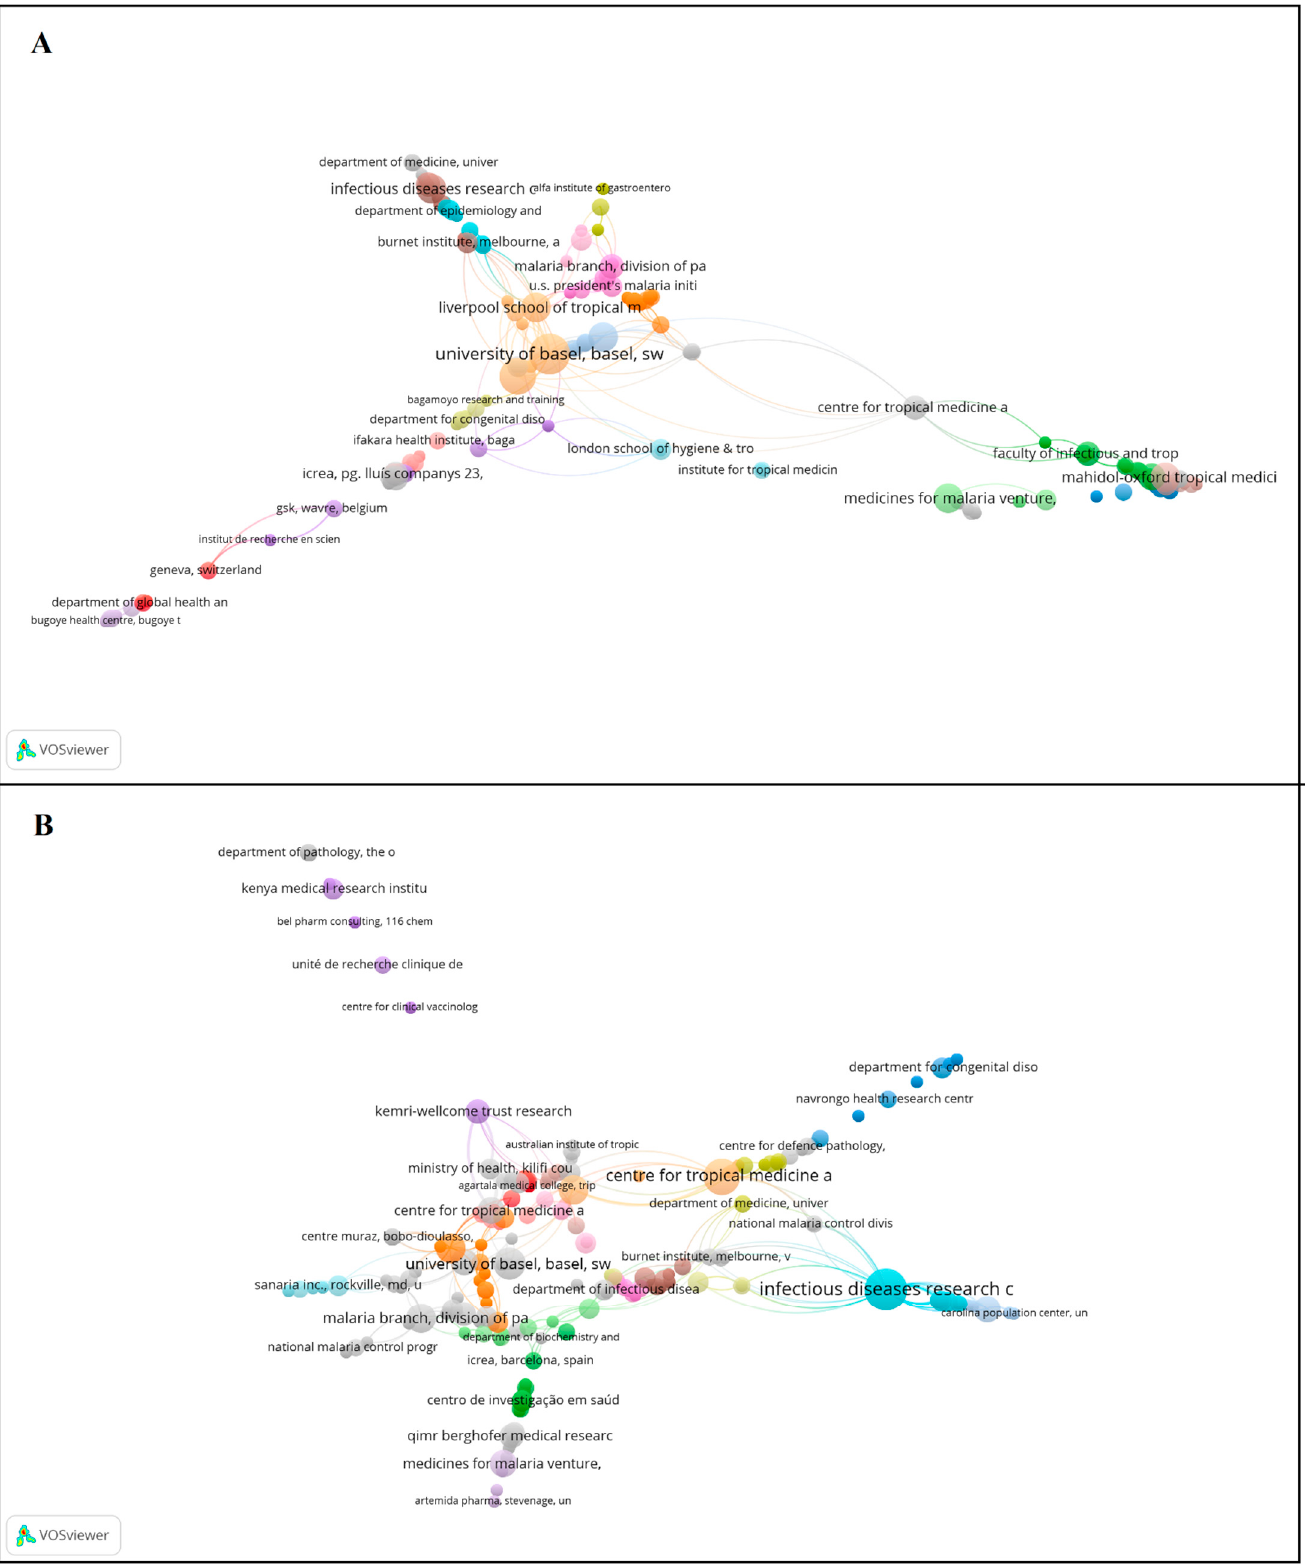
Figure 2. Affiliations of authors that contributed on malaria publications. ( A ) before the COVID-19 pandemic, ( B ) during the COVID-19 pandemic.